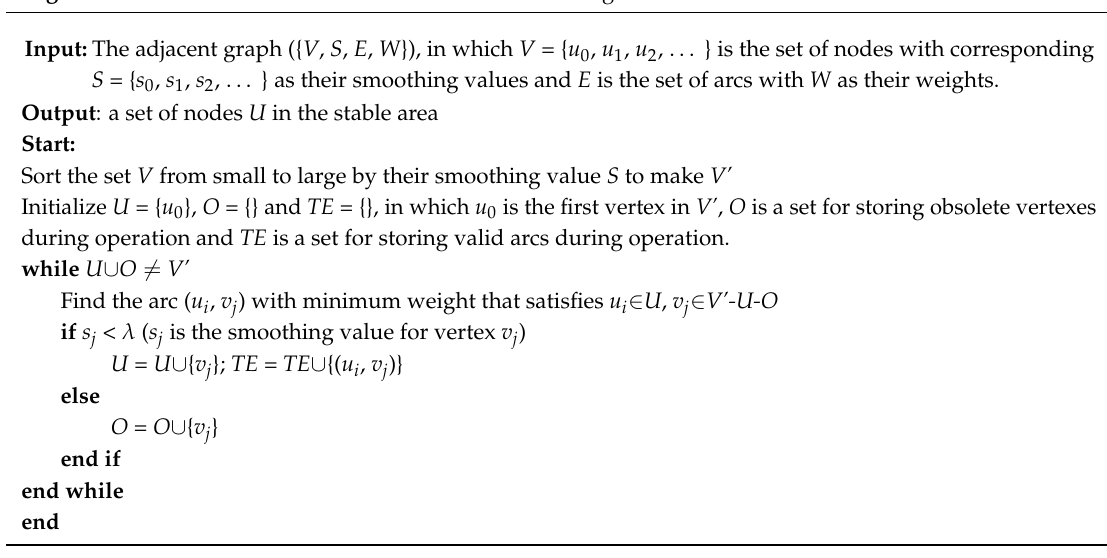
Algorithm 1. Procedure to find a stable area via a search